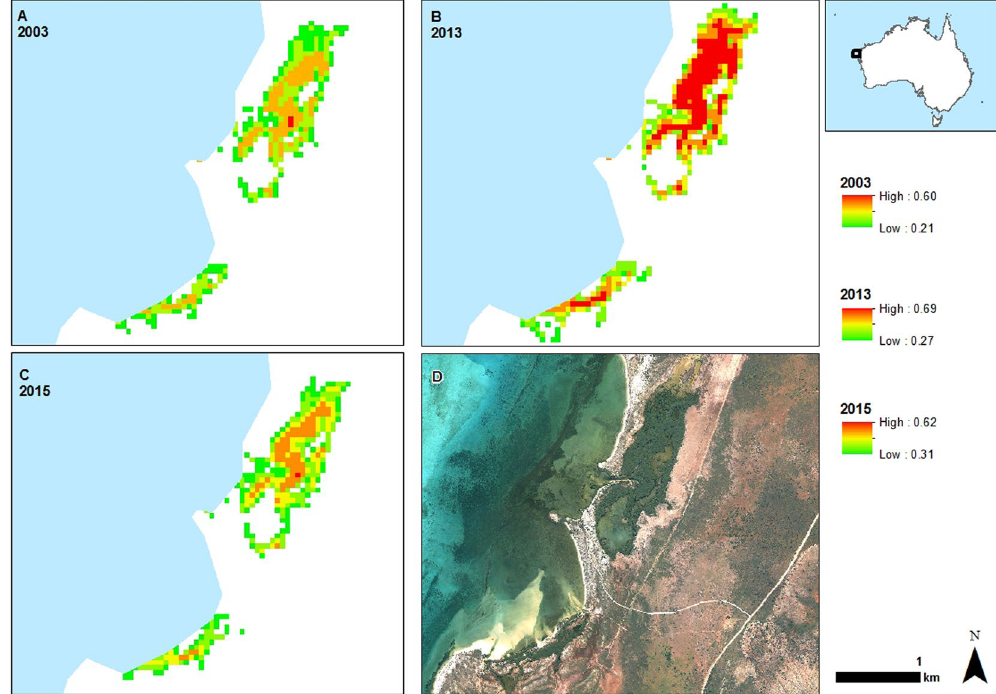
Figure 1. Normalized difference vegetation index (NDVI) of Mangrove Bay mangrove forest showing the thinning canopy during the dieback in 2003 associated with low sea level and high salinity of soil porewater ( A ), after recovery of the canopy in 2013 ( B ), and after the most recent downward swing of the sea level seesaw in 2015 ( C ). An aerial image of the site ( D ) shows the mangrove fringing small creeks and lagoons adjacent to the Ningaloo reef flat and the grassland dominated terrestrial environment. The location of Mangrove Bay on the Australian coast is shown in the inset. NDVI was obtained from Landsat scenes (Table S1), the aerial image from 2012 was obtained from © 1995–2016 Esri (Service Layer Credits: Source Esri, Digital Globe, GeoEye, Earthstar Geographics, CNES/Airbus DS, USDA, USGS, AEX, Getmapping, Aerogrid, IGN, IGP, swisstopp, and the GIS User Community). Geographic boundaries represent Australian Statistical Geography Standard (ASGS) provided by the Australian Bureau of Statistics (ABS, 2011, data freely available at http://www.abs.gov.au/ AUSSTATS/abs@.nsf/Lookup/1259.0.30.001 Main + Features1July%202011?OpenDocument). Map generated in ArcMap